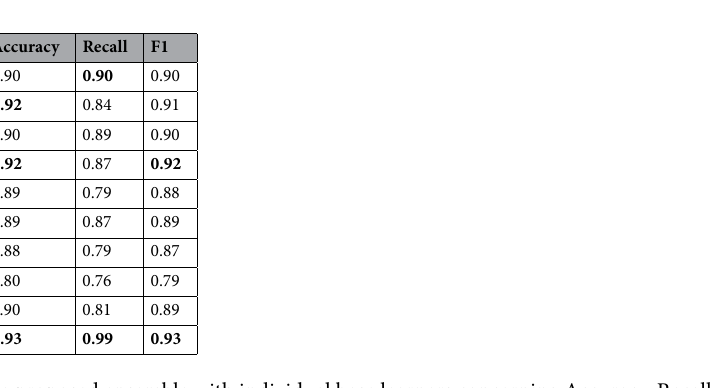
Table 4. Comparison of the proposed ensemble with individual base learners concerning Accuracy, Recall, and F1-score on zero-day test data. The black bold values show the top-1 results.